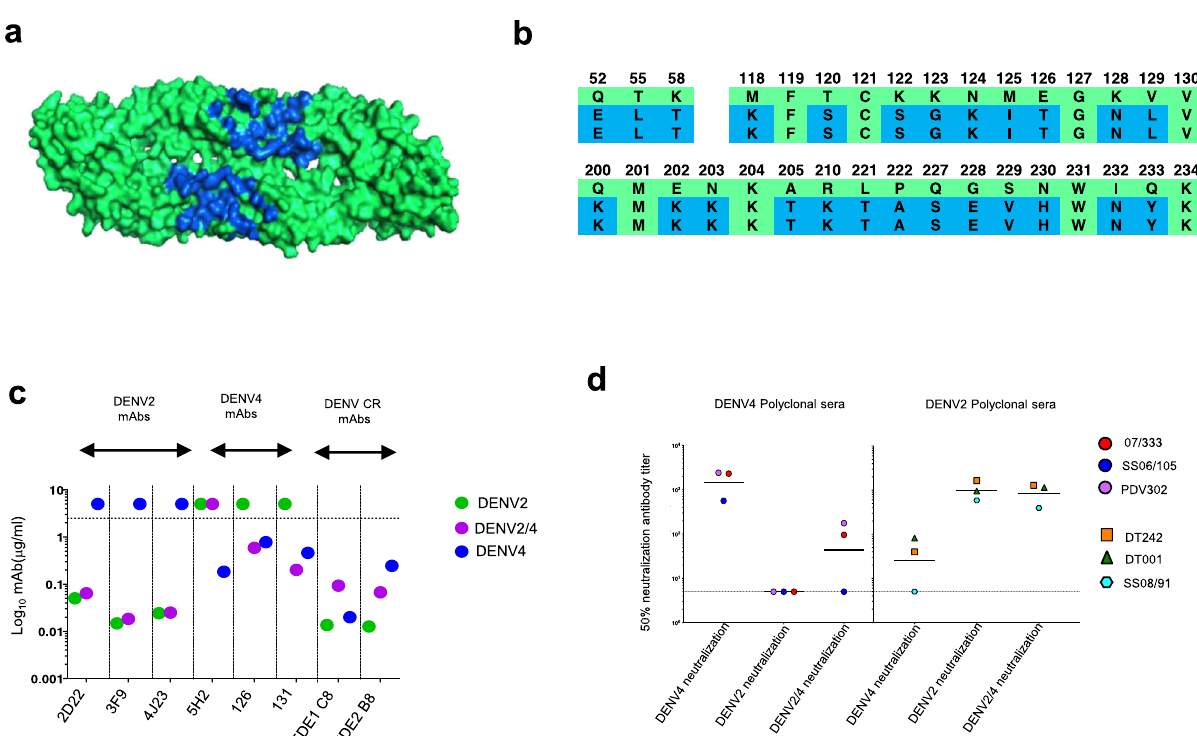
Fig. 3 Characterization of DENV4 126 and 131 epitope transplant rDENV (rDENV2/4) used for mapping the DENV4 responses. a Recombinant DENV2 containing EDI/II hinge, EDII residues from DENV4 that includes epitopes of the DENV4-126 and DENV4-131 mAbs. The fi gure depicts a model of DENV2 E protein dimer, with the mutated residues colored in blue. b Amino acid alignment of DENV2, rDENV2/4, DENV4, protein sequences in the EDI/II hinge; EDII regions with mutated residues in rDENV2/4 colored in blue. c Monoclonal antibodies (2D22, 3F9, 4J23: DENV2 TS mAbs, 5H2, 126,131: DENV4 TS mAbs, EDE1 C8, EDE2 B7 pan DENV speci fi c mAbs) neutralization of rDENV2/4 compared to each parental strain ’ s is shown. Data shown here was from a single independent experiment and represented as mean neutralization titers. d Characterizing the neutralizing properties of DENV2 ( n = 3) and DENV4 ( n = 3) polyclonal natural infection sera against rDENV2/4 and the parental viruses. Data were obtained from a single independent experiment and expressed as mean